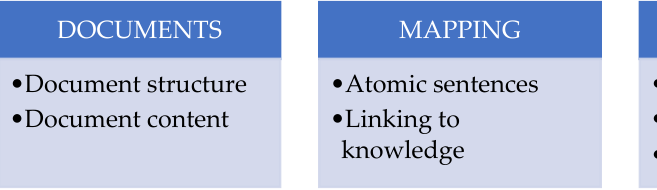
Figure 3. The main layers of the proposed ontology structure.